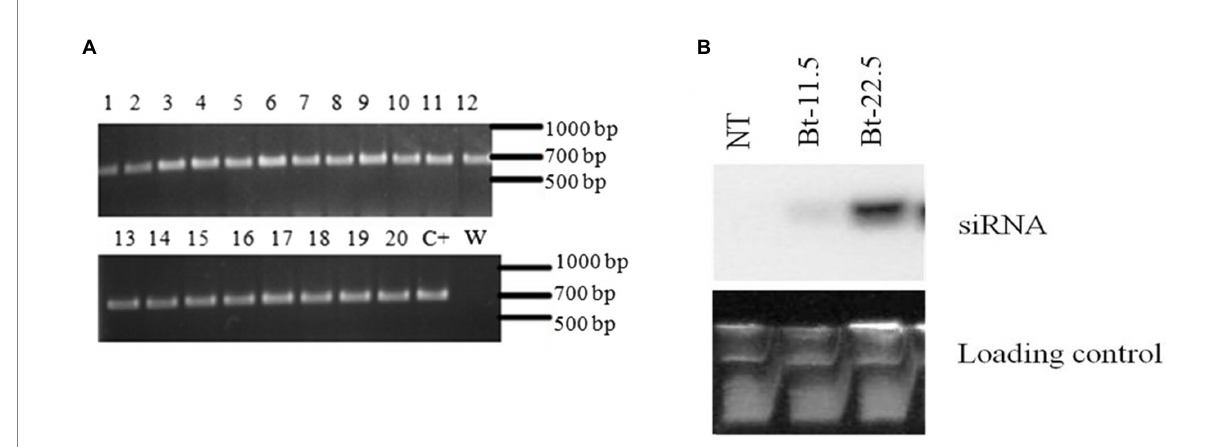
FIGURE 2 Analysis of common bean transgenic plants and relative expression of the vATPase gene in the whitefly Bemisia tabaci . (A) Progeny analysis of the transgenic common bean line Bt-22.5 for the marker gene ahas . Numbers 1 to 20 correspond to the 20 T 2 plants from seeds collected from plant Bt-22.5, C+ is the positive control and W is water, used as negative control. (B) Northern blot analysis for the detection of Bemisia tabaci vATPase small interfering RNA (siRNA) isolated from transgenic common bean lines Bt-11.5 and Bt-22.5. NT is the non-transgenic common bean cv. Olathe Pinto. SYBR Safe stained RNA served as loading